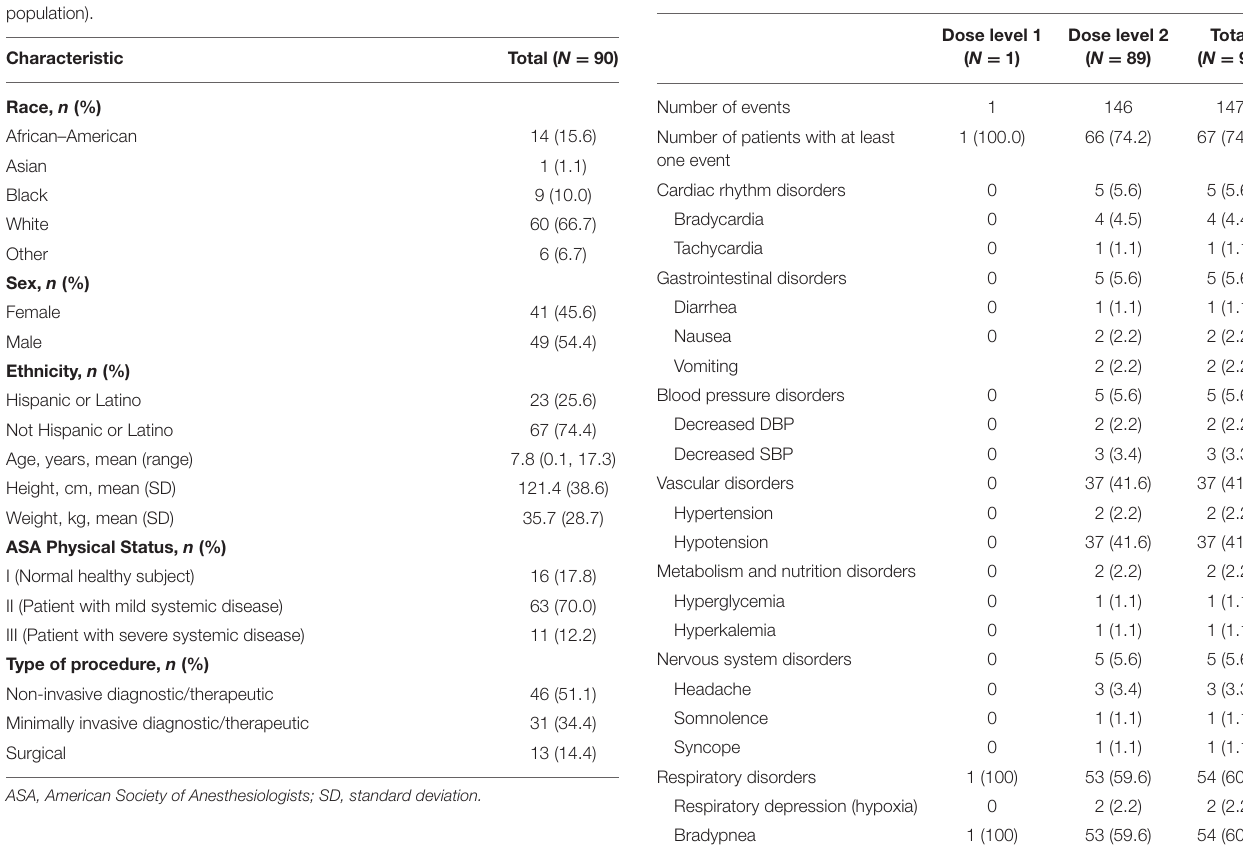
TABLE 4 | Summary of treatment-emergent adverse